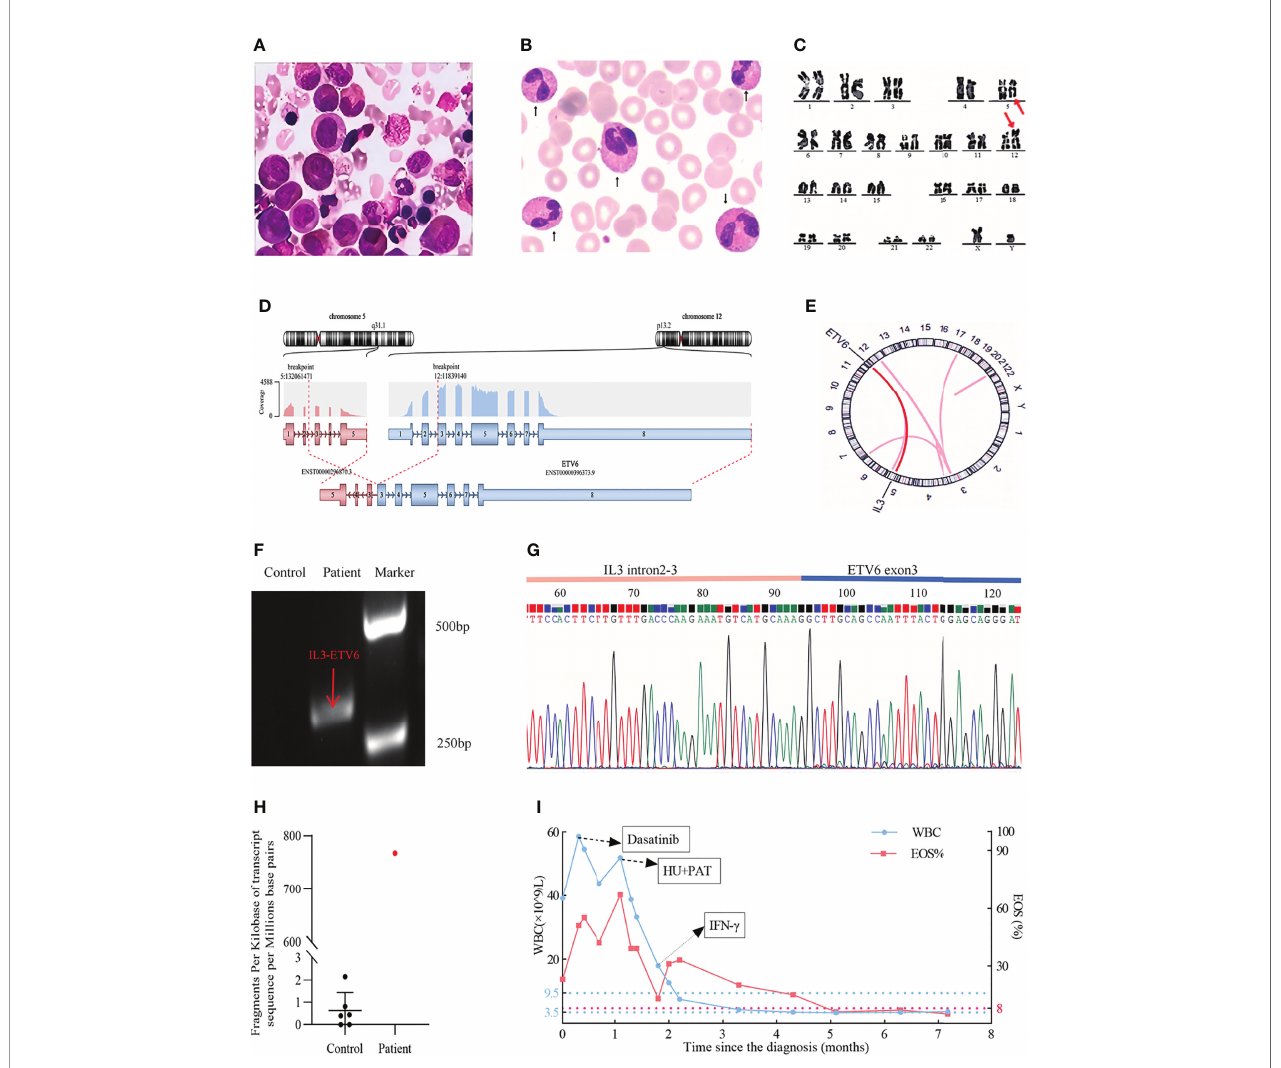
FIGURE 1 | (A) A signi fi cantly increased eosinophil ratio was shown on a bone marrow (BM) smear (Wright – Giemsa stained, x 100). (B) Signi fi cantly increased eosinophilia was observed on a peripheral blood (PB) smear (× 100), the arrows delineated eosinophils. (C) Karyotypic analysis of BM showed the translocation of t (5; 12) (q31; p13) (delineated by arrows). (D) RNA-sequencing analysis indicated the IL3-ETV6 fusion. (E) Circos plot displaying the interconnectivity between IL3 and ETV6 . (F) Ampli fi ed IL3-ETV6 transcripts by RT – PCR. Control: water. The predicted product was 300bp, and the patient ’ s PCR product was indicated by red arrow. (G) Sanger sequencingof the PCR product ( IL3-ETV6 ). (H) IL3 mRNA was obviouslymorehighlyexpressed than in other eosinophiliapatients with normal karyotypes. Control:CEL-NOS patients with normal karyotype, FPKM: fragments per kilobase of transcript sequence per millionsbase pairs sequenced. (I) Fluctuation ofthe patient ’ s peripheral white blood cellcount (WBC, ×10 9 /L) andeosinophilratio (EOS,